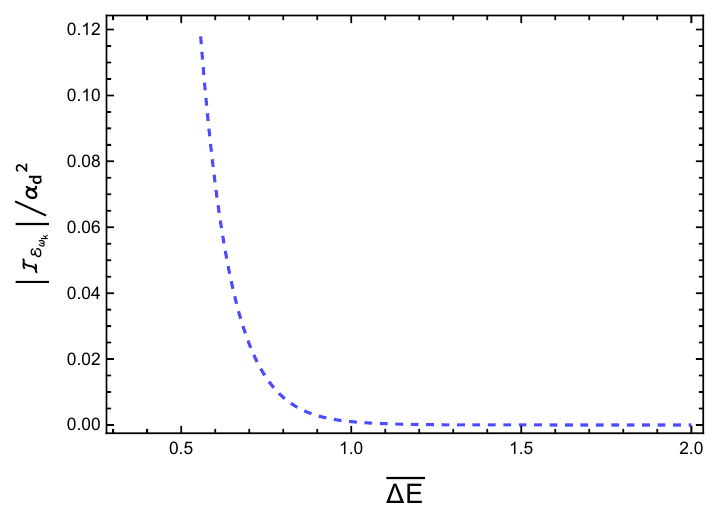
is plotted for two outgoing null detectors in a (1+1) dimensional | /α 2 d ωk = 0 . 2 , and fixed d/α = 0 k d